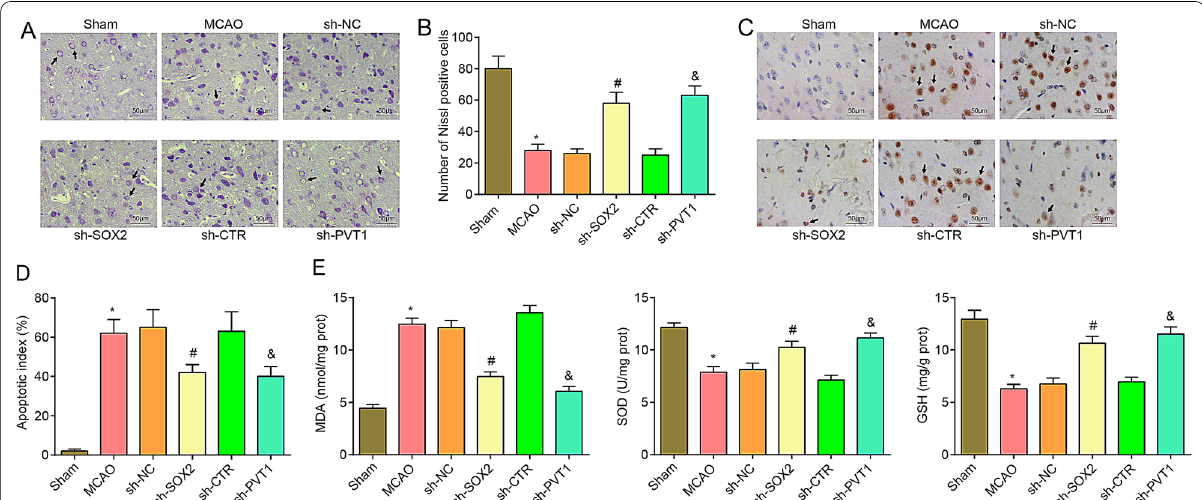
Fig. 4 Depleted SOX2 or PVT1 increases neuronal survival, reduces neuronal apoptosis and oxidative stress in the cerebral cortex of MCAO rats. A / B Nissl staining of neuron survival in each group after inhibition of SOX2 or PVT1 ( Nissl bodies; C / D TUNEL staining of neuronal apoptosis in each group after inhibition of SOX2 or PVT1 ( group); arrows indicated TUNEL-positive cells; E Oxidative stress indicators in the cortex of rats in each group after inhibition of SOX2 or PVT1 (n 8 rats per group); * P < 0.05 compared with the sham group; # P < 0.05 compared with the sh-NC group; & P < 0.05 compared with the sh-CTR =